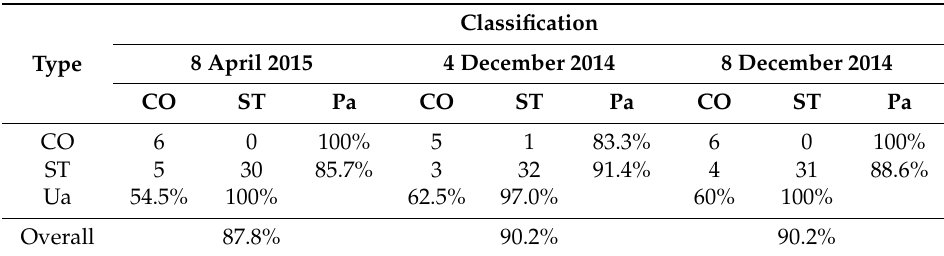
Table 4. Classification results with all features (CO = totally collapsed building, ST = standing building; Pa = producer’s accuracy, Ua = user’s accuracy).